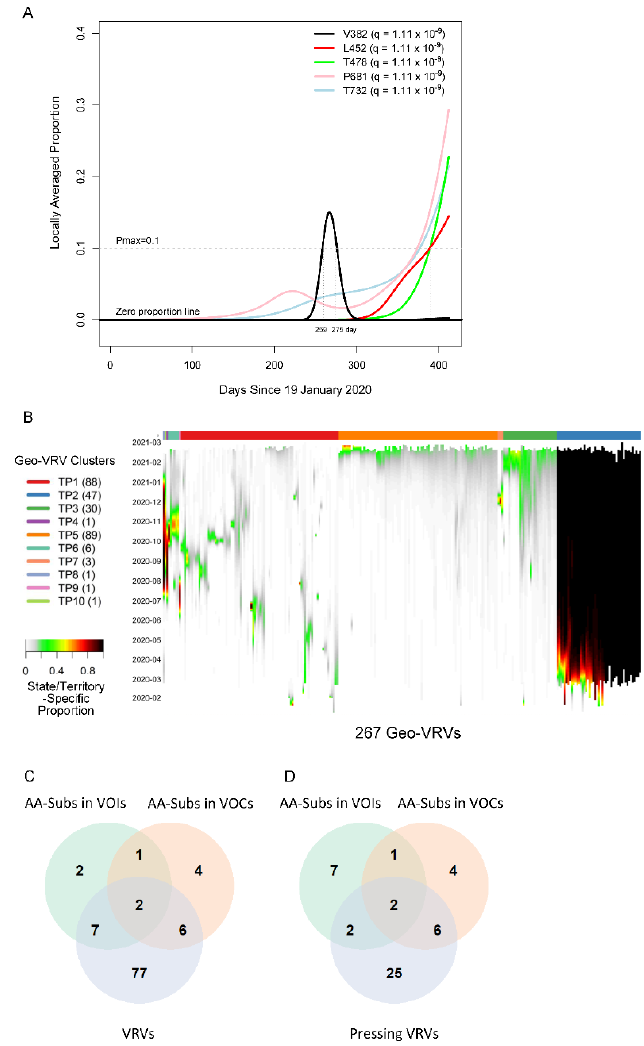
Figure 1. Viral residue variant (VRV) spatiotemporal patterns in the United States. ( A ) Locally averaged proportions over time of five VRVs (V382, L452, T478, P681 and T732), modeled using sequences from California. The horizontal gray dotted line denotes the maximum proportion (Pmax) cutoff of 10% (see the formula for calculating Pmax in section 3.3.1 of Materials and Methods). V382 exceeded the Pmax cutoff of 10% on day 259 and dropped below the Pmax cutoff of 10% on day 275 (marked by the vertical gray lines). ( B ) Heatmap of the 267 identified geo-VRVs, with color designating the state/territory-specific VRV proportion at the sampling time as designated on the left-hand vertical axis. Geo-VRVs with similar temporal dynamics are grouped into 10 clusters (TP1 through TP10), as designated by the color bar at the top of the heatmap. ( C , D ) Venn diagrams showing the relationships between AA-subs in VOIs, AA-subs in VOCs, and ( C ) VRVs or ( D ) pressing VRVs. AA-subs, amino acid positions that have been shown to harbor substitutions within US-circulating variants; VOCs, variants of concern; VOIs, variants of